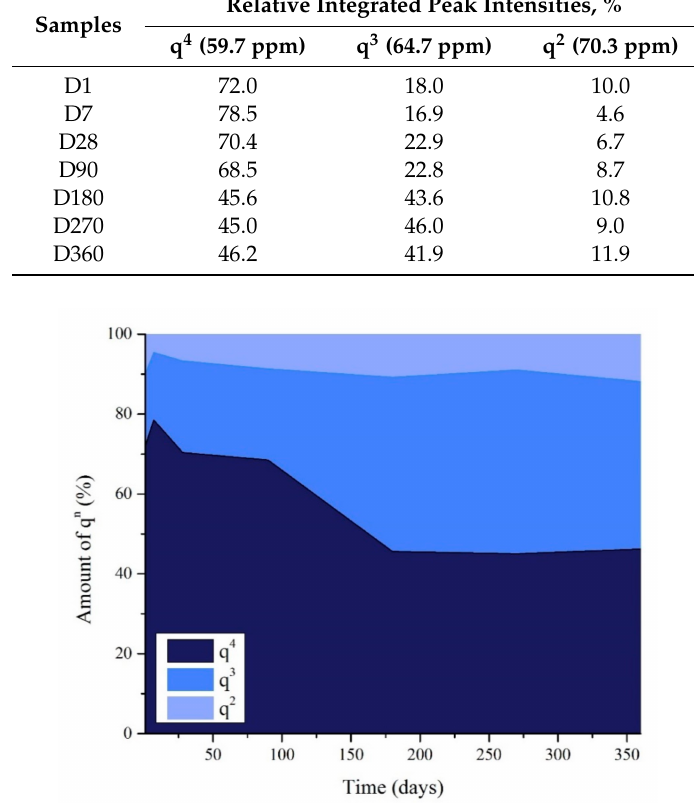
Figure 9. Amount of q 2 , q 3 and q 4 sites aluminum present in the pore solution at ages between 1 day and 1